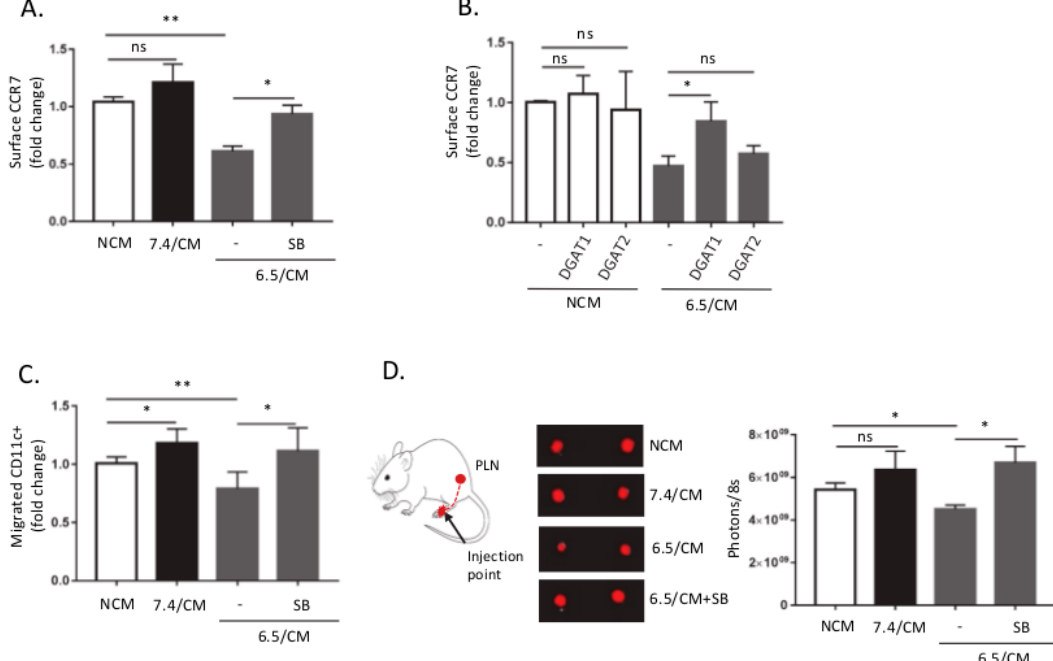
Figure 3. Dendritic cells (DCs) exposed to acidic mesothelioma milieu exhibit reduced migratory potential in vitro and in vivo. DCs were incubated with non-conditioned medium (NCM) or treated for 2 days either with conditioned medium from Ab1 mesothelioma cells maintained at pH 7.4 or pH 6.5 (7.4 / CM and 6.5 / CM, respectively). ( A , B ) E ff ects of 6.5 / CM with or without 5 µ M SB-431542 ( A ) and either 15 µ M A922500 (DGAT1i) or 10 µ M PF-06424439 (DGAT2i) ( B ) on CCR7 surface expression as determined by flow cytometry ( n = 3, * p < 0.05, ** p < 0.01, ns = non-significant). ( C , D ) E ff ects of 5 µ M SB-431542 on DC migration determined either in vitro in transwell migration assay ( n = 3, * p < 0.05, ** p < 0.01, ns = non-significant) ( C ) and in vivo in the mouse footpad assay as depicted in ( D ) together with representative pictures and quantification of VivoTrack 680 NIR fluorescence signal into popliteal lymph nodes collected 3 days post-injection ( n = 5 − 6, * p < 0.05; ns = non-significant).